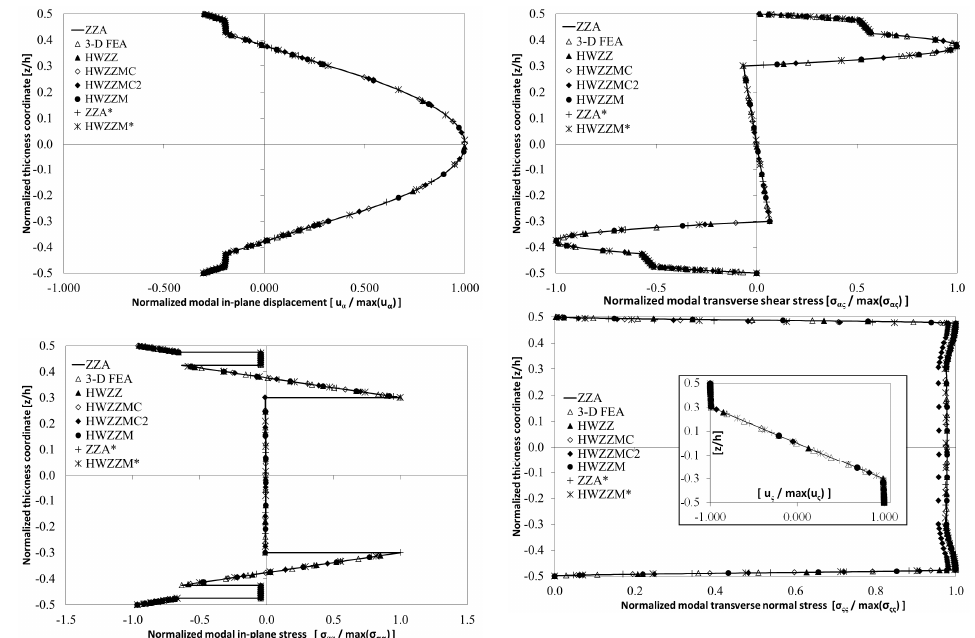
Figure 10. Case g: Normalized modal displacements and stresses of a simply supported sandwich plate in cylindrical bending ( L x/ h = 5, third mode).